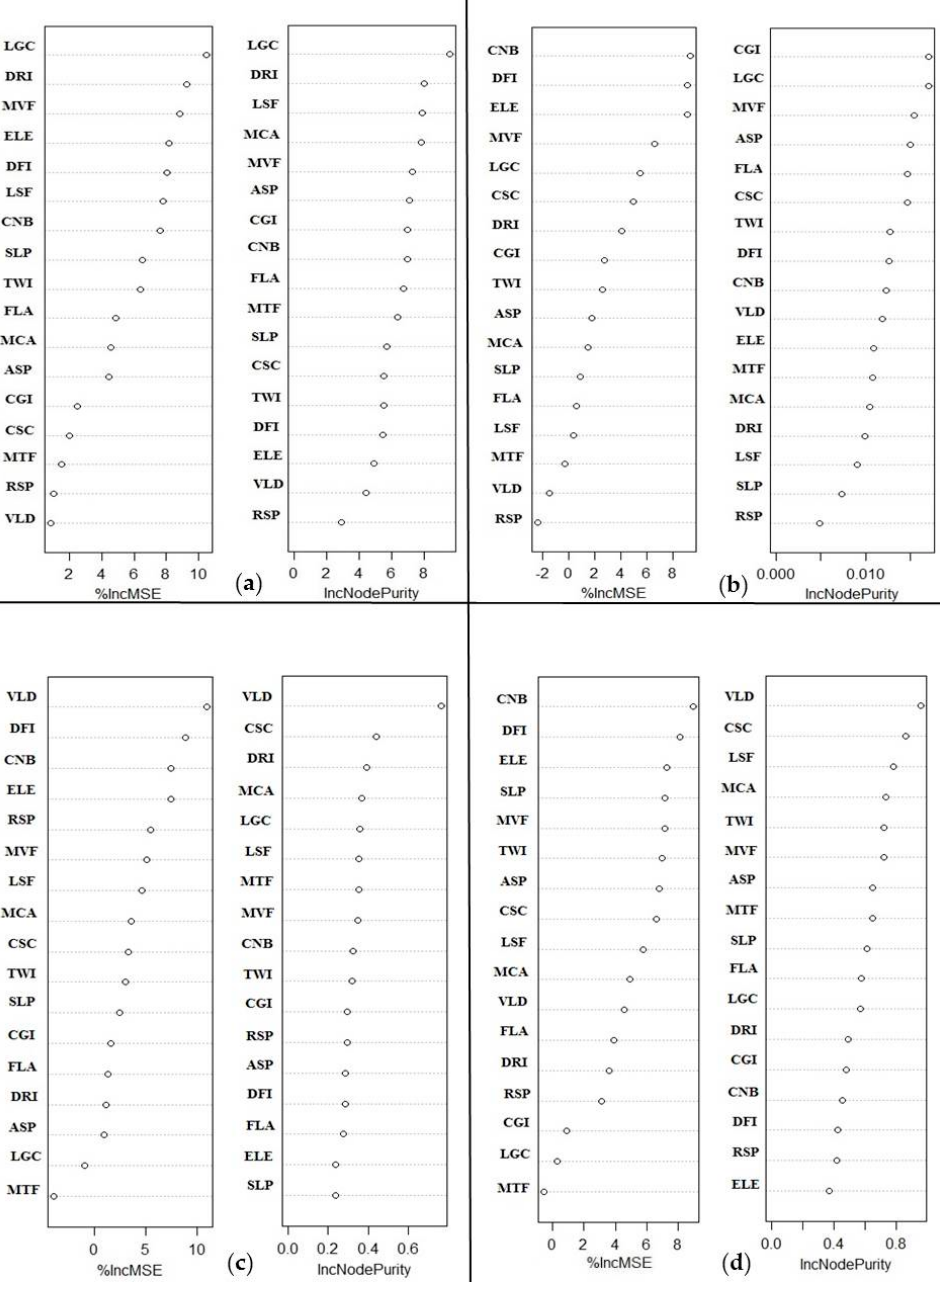
Figure 4. We used RF model to rank the covariate importance for the studied properties: ( a ) TG; ( b ) EEG; ( c ) TG/OC; and ( d )